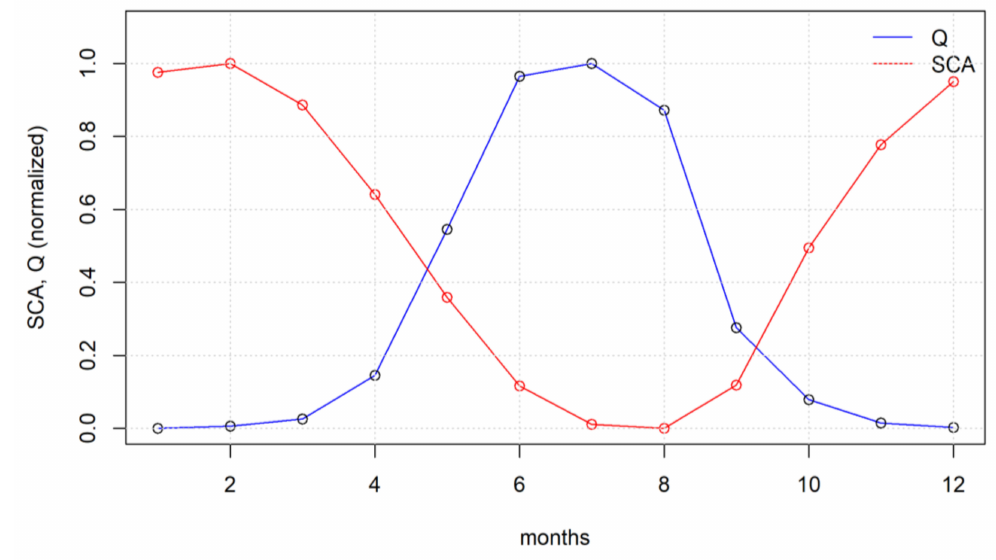
Figure 2. Discharge and Snow cover evaluation of Naryn river basin. The data is averaged from 3 hydrological stations (Big-Naryn, Naryn, Uch-Terek